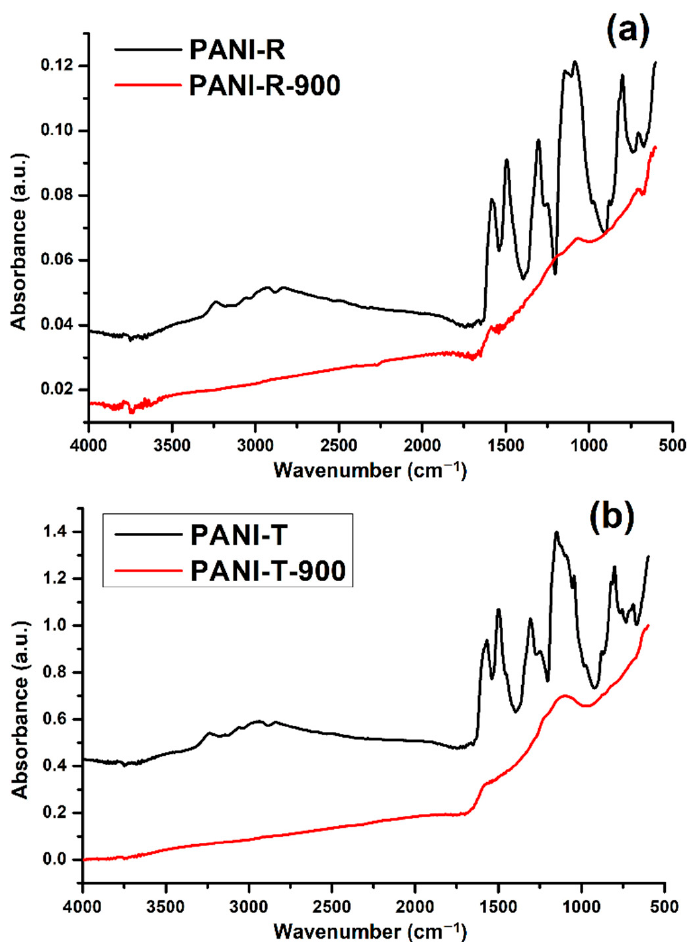
Figure 2. FTIR spectra of ( a ) PANI-R and PANI-R-900 and ( b ) PANI-T and PANI-T-900 samples .